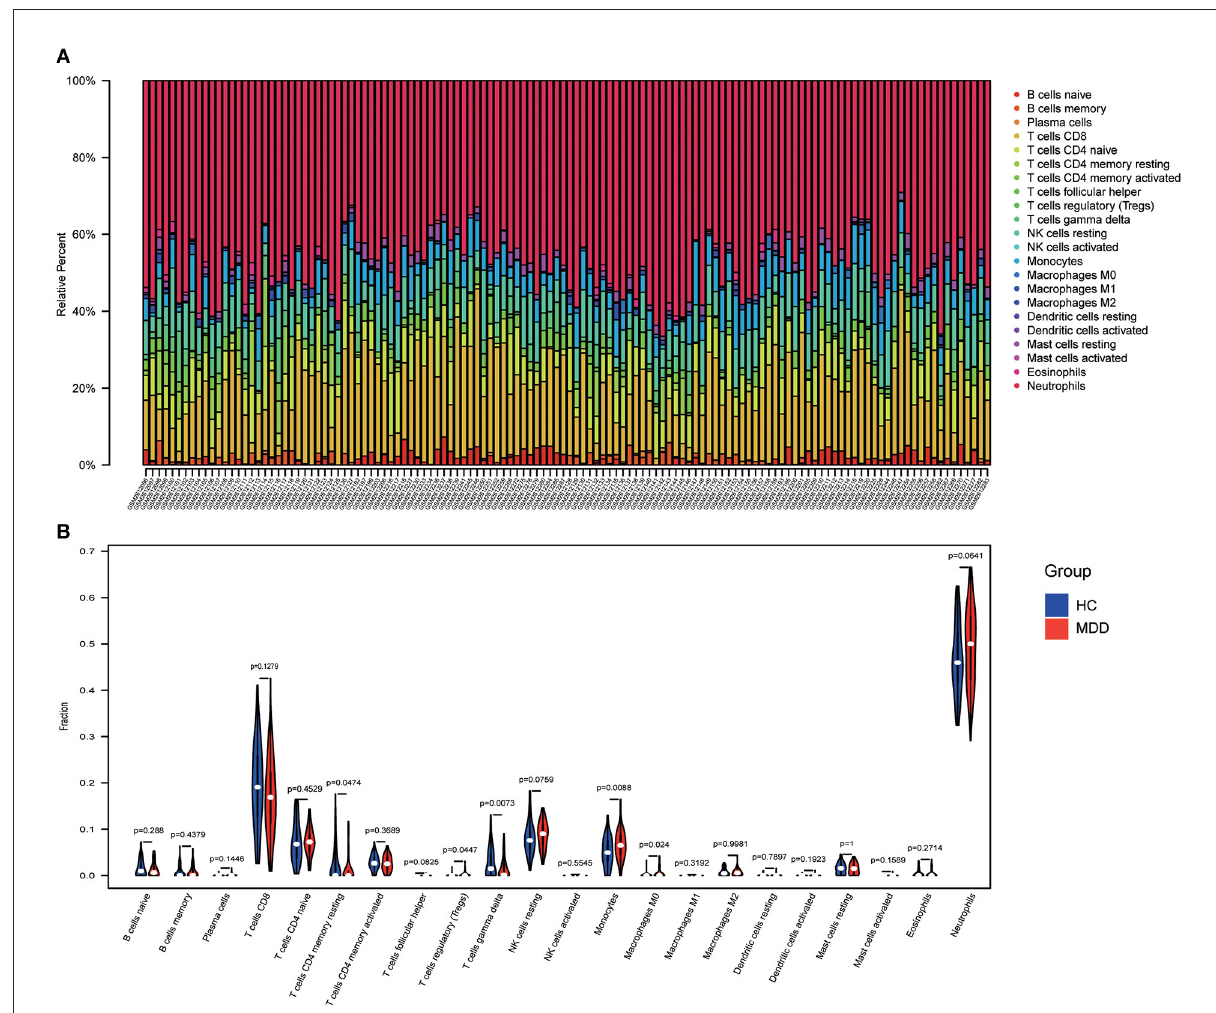
FIGURE11 Immune infiltration analysis. (A) A bar chart showing the proportions of 22 different types of immunocytes in the GSE98793 dataset. (B) The violin plot shows the difference in immune infiltration between healthy control (HC) and MDD